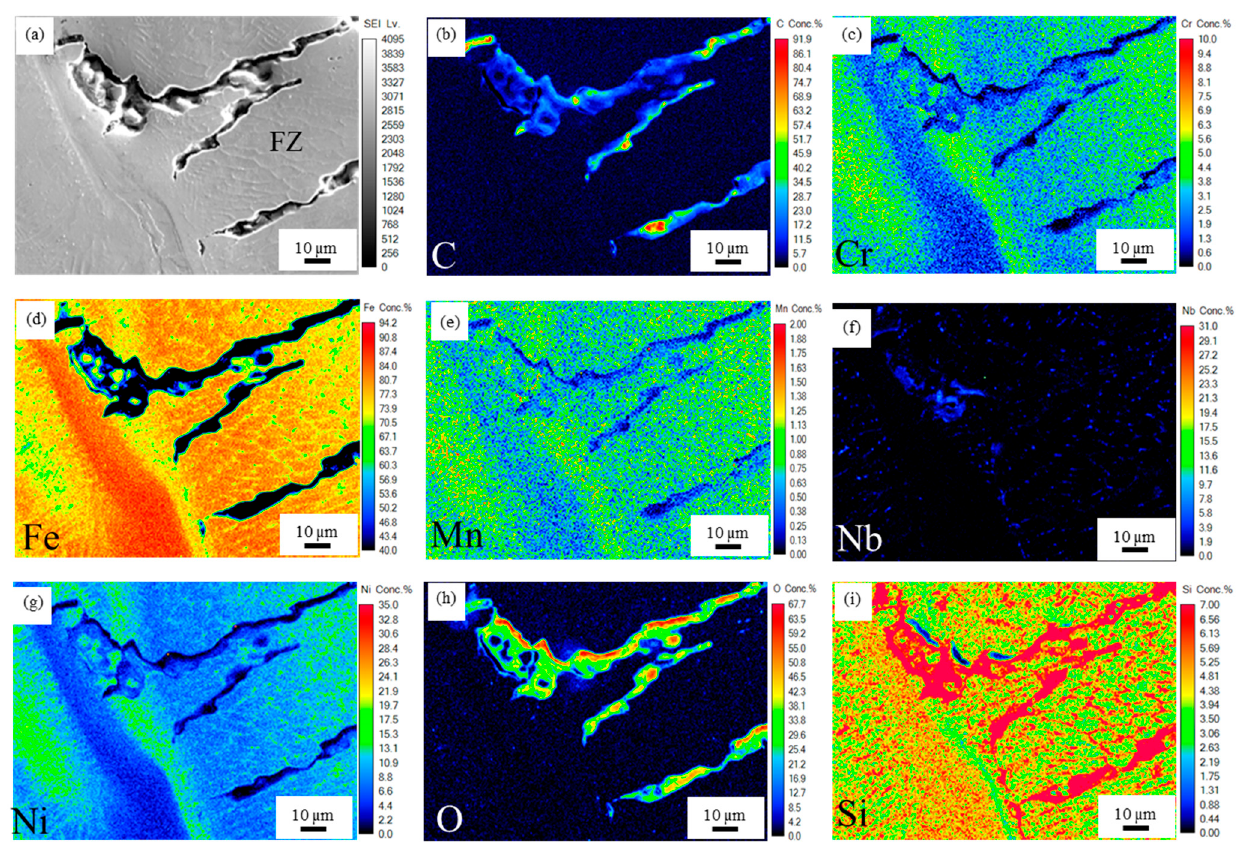
Figure 8. Selected area in Figure 6a at higher magnification: ( a ) EPMA SEI, ( b – i ) WDS quantitative mappings of C, Cr, Fe, Mn, Nb, Ni, O and Si in at%.